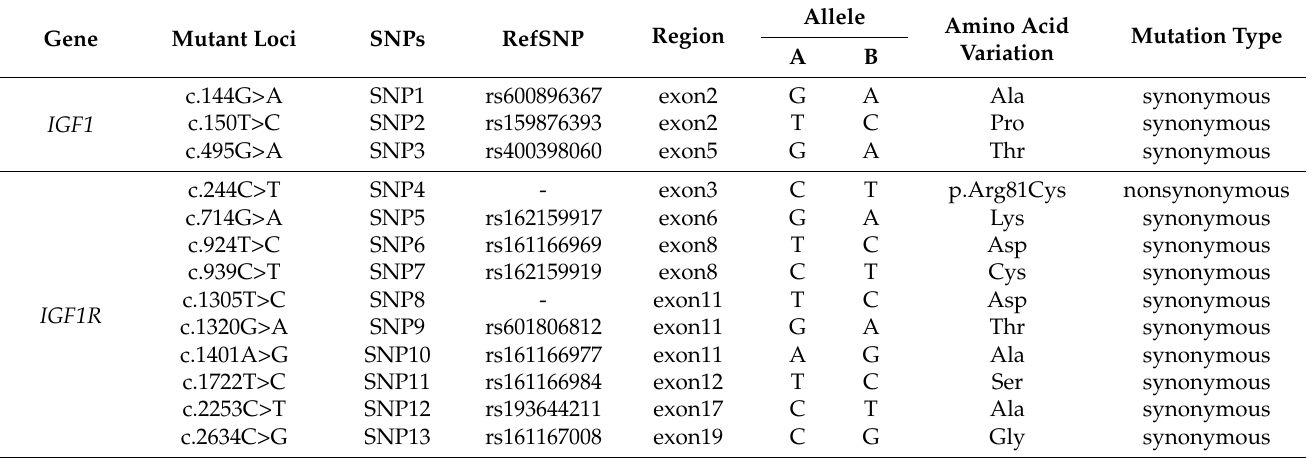
Figure 1. The sequencing peaks for three SNP loci of the IGF1 gene in Hulun Buir sheep. SNP1: c.144G>A (rs600896367); the arrow indicates the G–A mutation site. SNP2: c.150T>C (rs159876393); the arrow indicates the T–C mutation site. SNP3: c.495G>A (rs400398060); the arrow denotes to the G–A mutation site. Table 1. The information of SNP in IGF1 and IGF1R in Hulun Buir